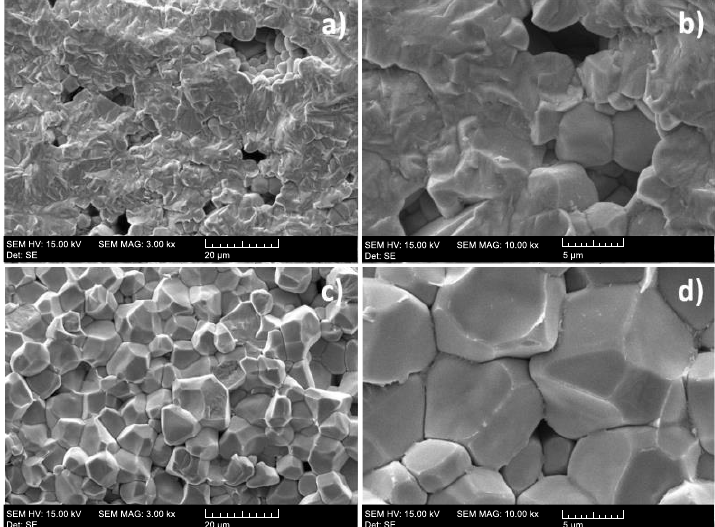
Figure 5. SEM images of fractured surfaces of ( a ) soft PZT ceramics (3000×), ( b ) soft PZT ceramics (10,000×), ( c ) hard PZT ceramics (3000×) and ( d ) hard PZT ceramics (10,000×).